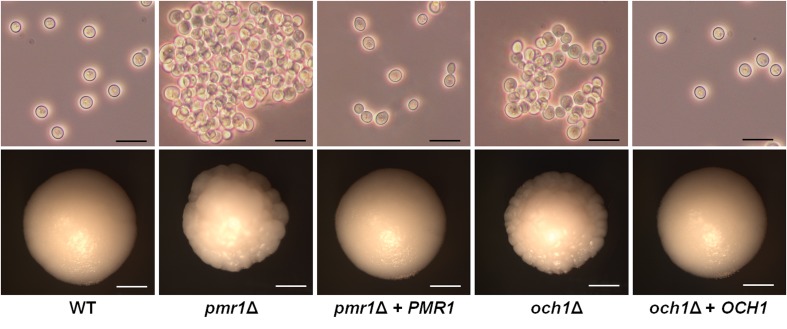
Cell and colony morphology of Candida tropicalis pmr1Δ and och1Δ null mutants. The upper panels show the cell morphology after growth at 28°C for 15 h in YPD medium, demonstrating cell aggregates in both null mutant strains. Scale bar, 10 μm. The lower panels show colony morphology after 3 days of growth at 28°C on YPD plates. Both null mutants formed colonies with irregular borders and a wrinkled surface. Scale bar, 1 mm. Strains used are MYA-3404 (WT), HMY207 (pmr1Δ), HMY208 (pmr1Δ + PMR1), HMY181 (och1Δ), and HMY205 (och1Δ + OCH1).